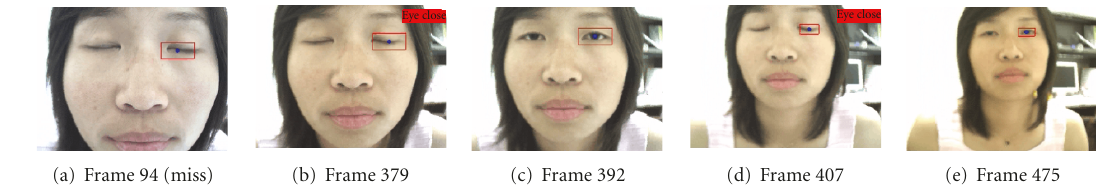
Figure 2: Examples of the blink detection results for indoor videos. Red boxes are tracked eyes, and the blue dots are the center of the eye locations. The red bar on the top-left indicates the presence of closed eyes.